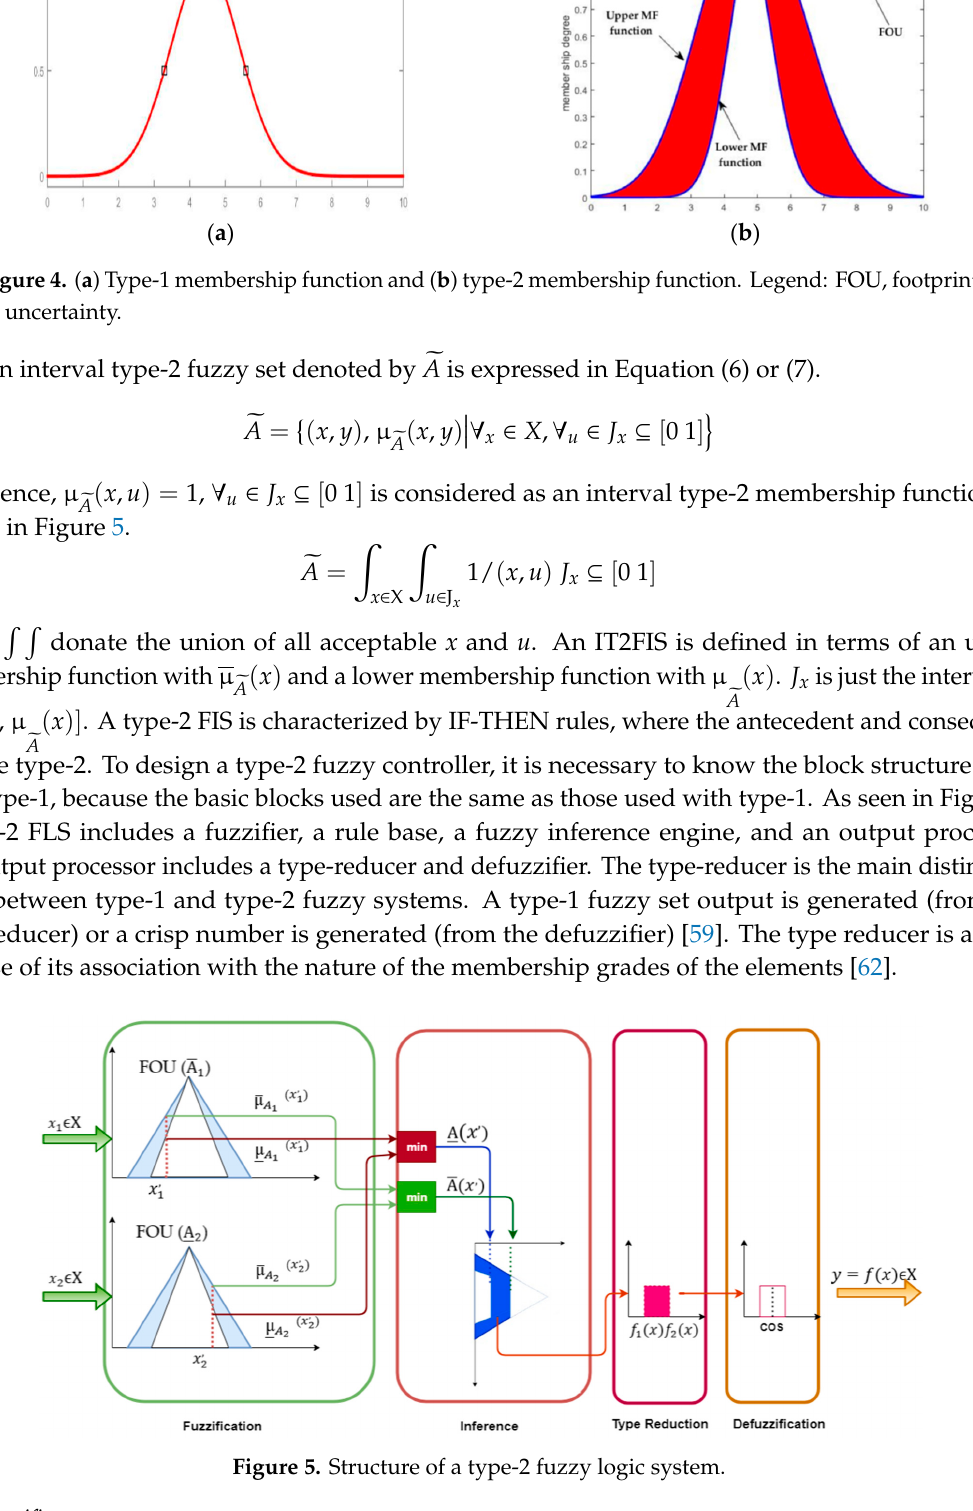
Figure 4. ( a ) Type-1 membership function and ( b ) type-2 membership function. Legend: FOU, footprint of uncertainty.